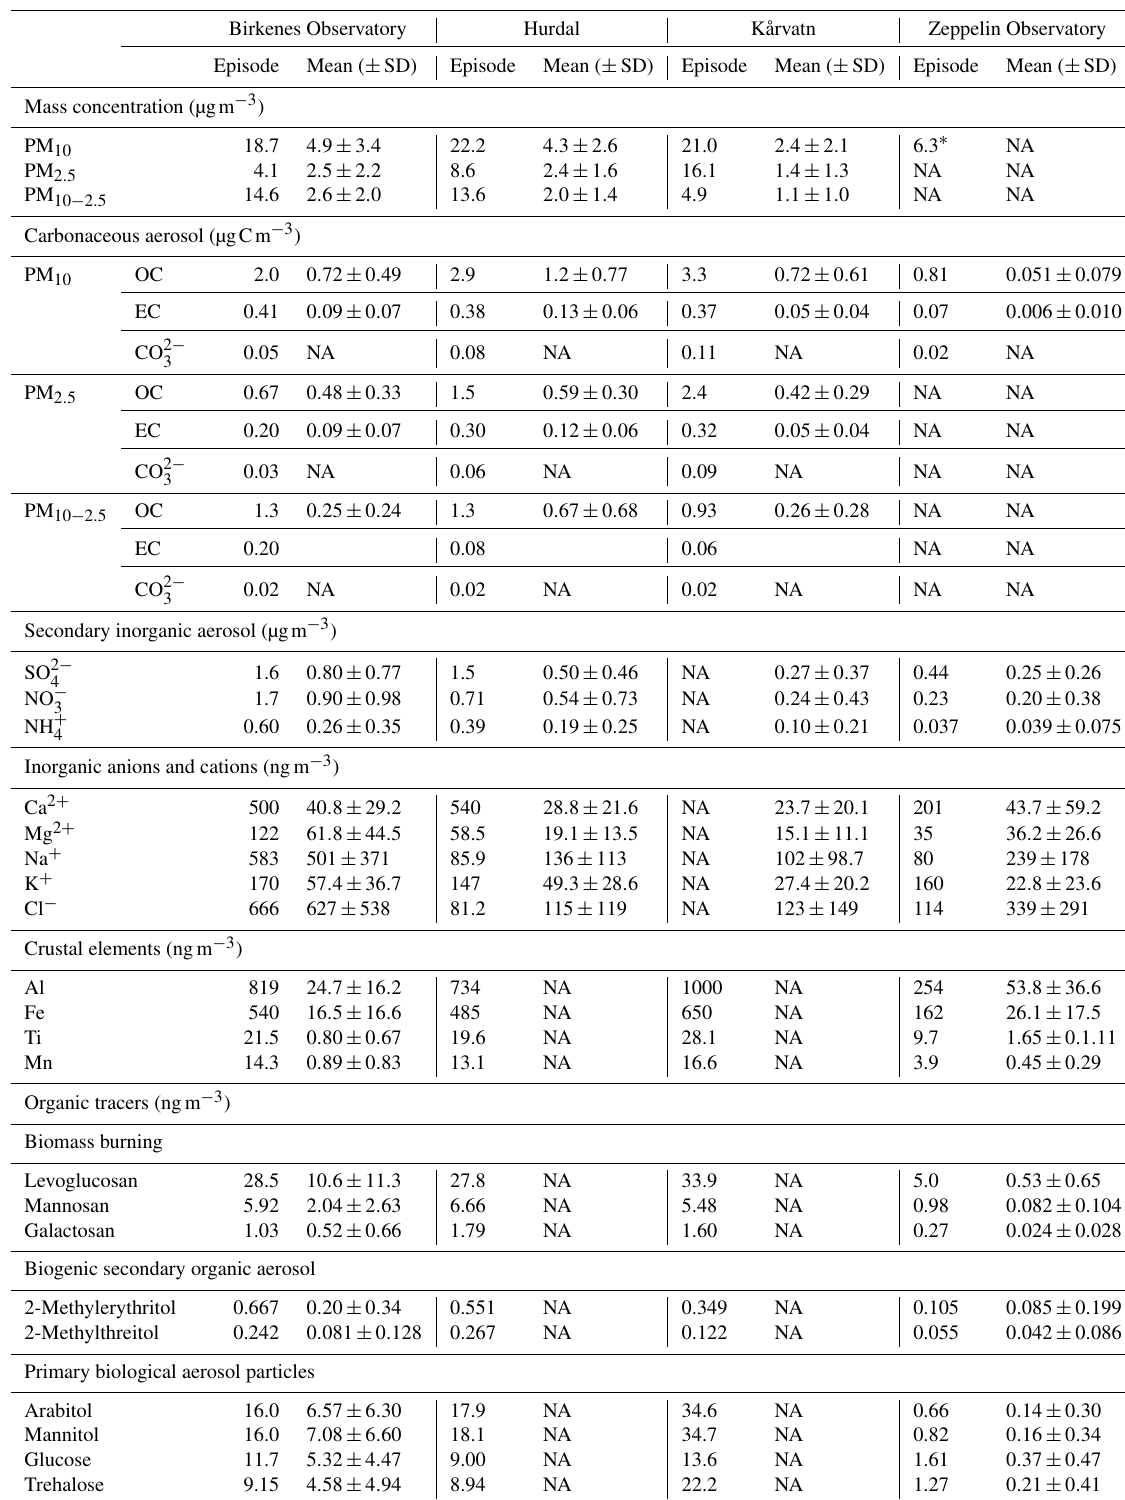
Table 1. Mean concentrations of PM and associated species observed during the episode compared to the long-term weekly mean ( ± SD)